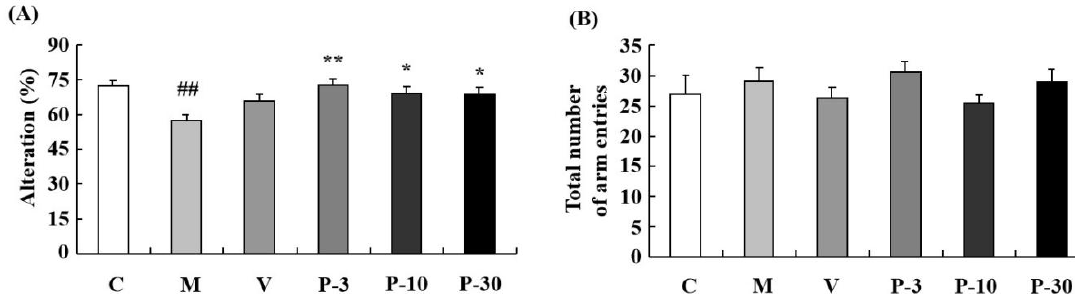
Figure 4. PAE effects on D -gal-induced memory impairment in the Y-maze test. The mice were placed at the end of one arm and allowed to explore in the Y-maze freely. The number of arm entries and sequence of arm visits was recorded manually for each mouse for 8 min. ( A ) The alternations and ( B ) total number of arm entries in the Y-maze. Results are presented as mean ± SEM. n = 9, ## p < 0.01 vs. vehicle control group and * p < 0.05, ** p < 0.01 vs. D-gal-treated group in the Y-maze. C, control group,